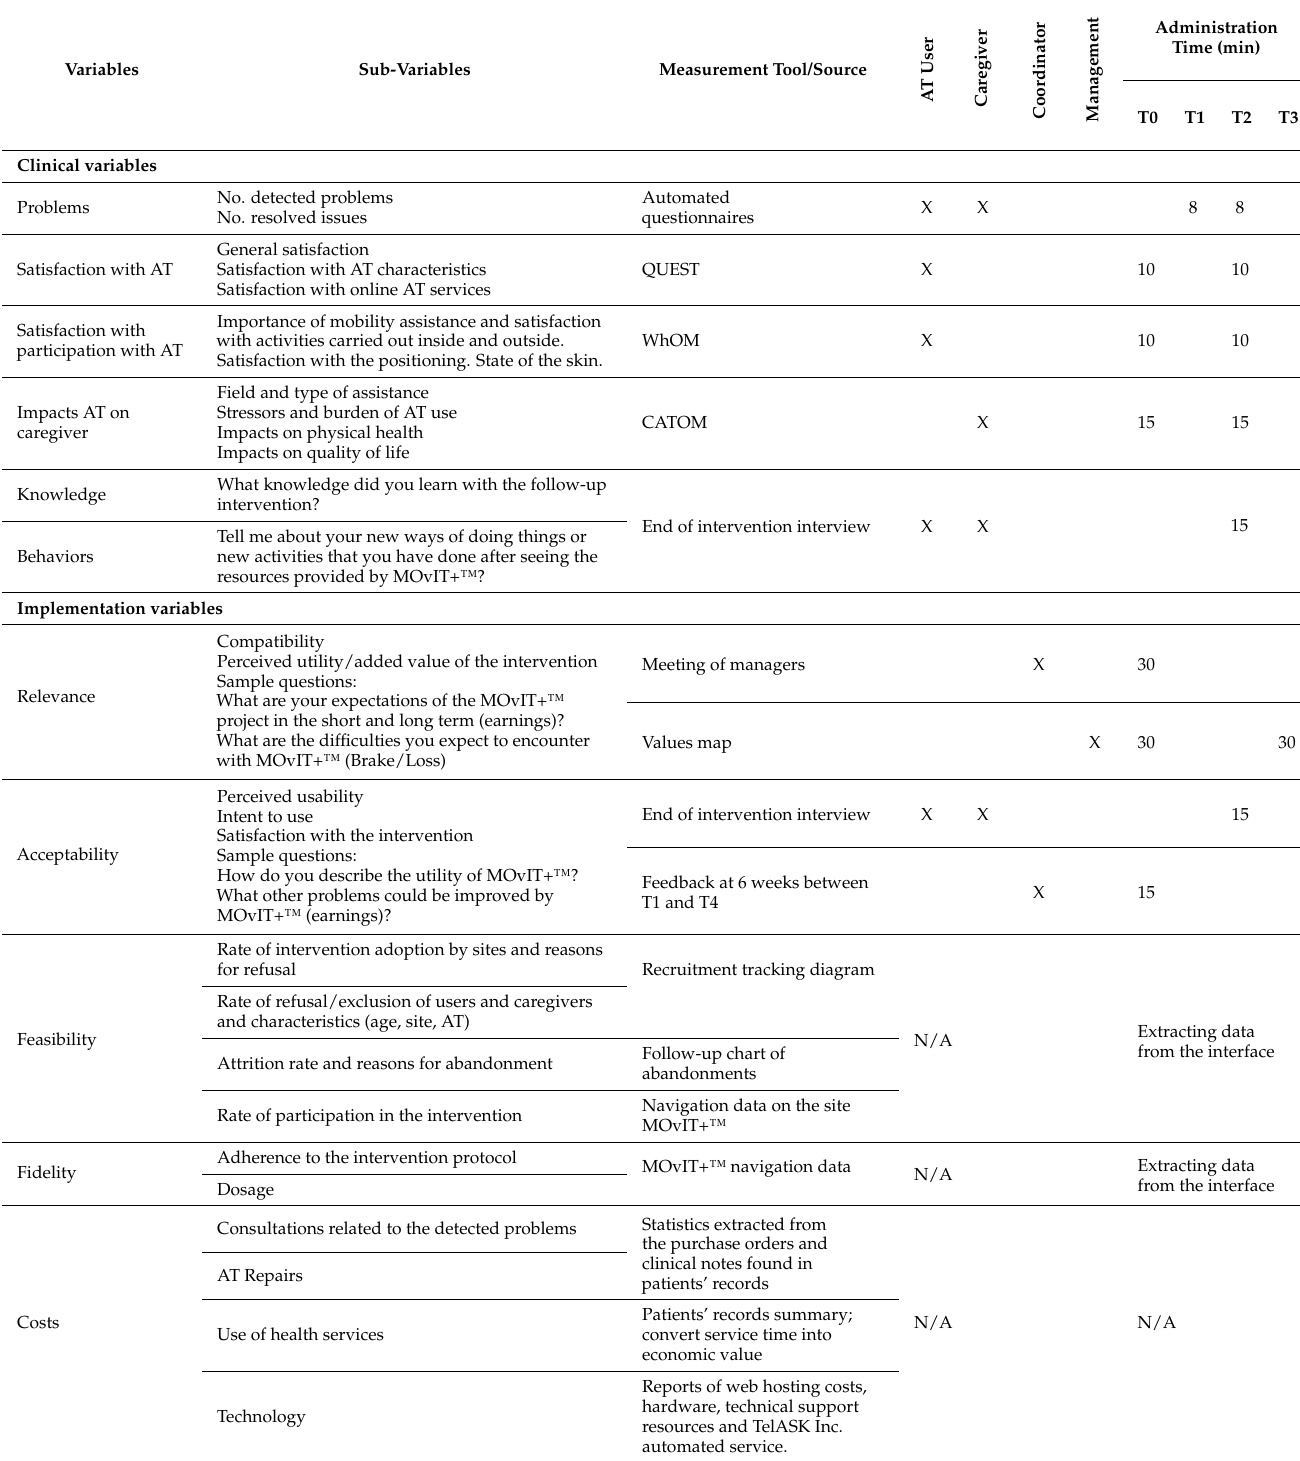
Table 3. Clinical and implementation